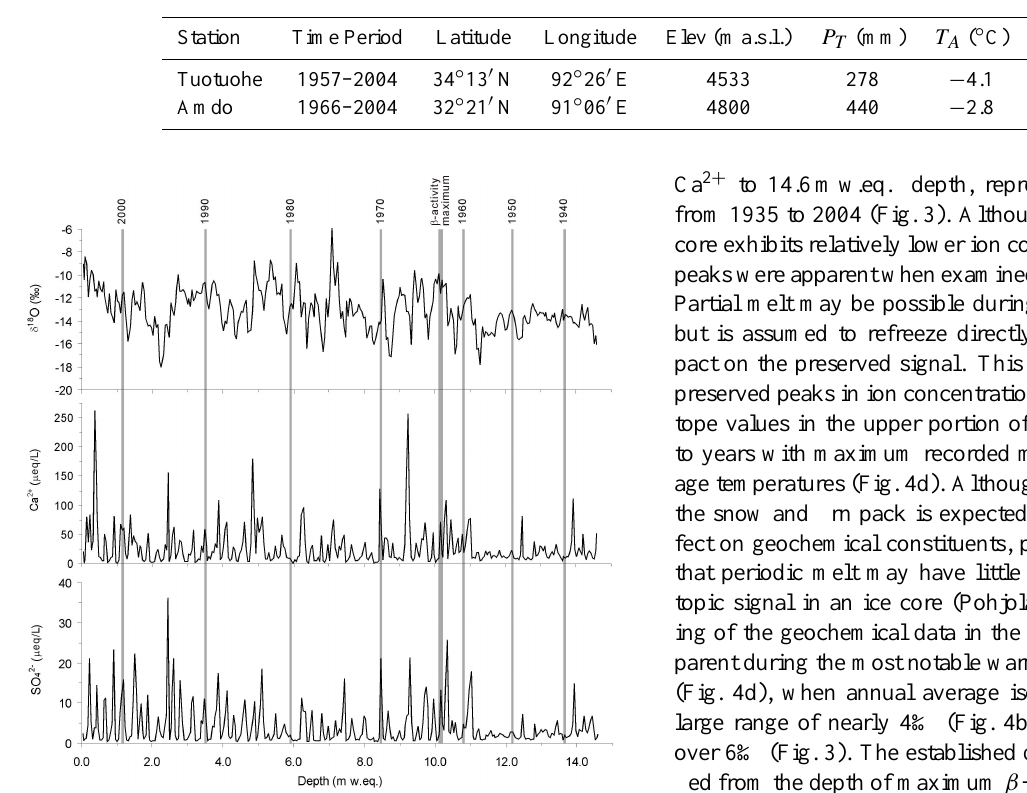
Table 1. Meteorological station summary data. P T is average total precipitation, T A is average annual temperature, and T M is average monsoon (JJAS) temperature.